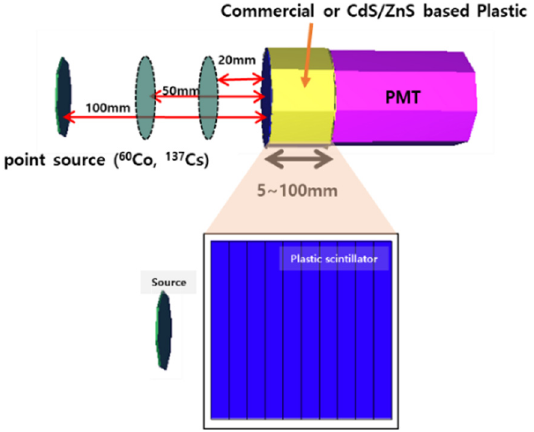
Figure 7. Geometry for application to MCNP.